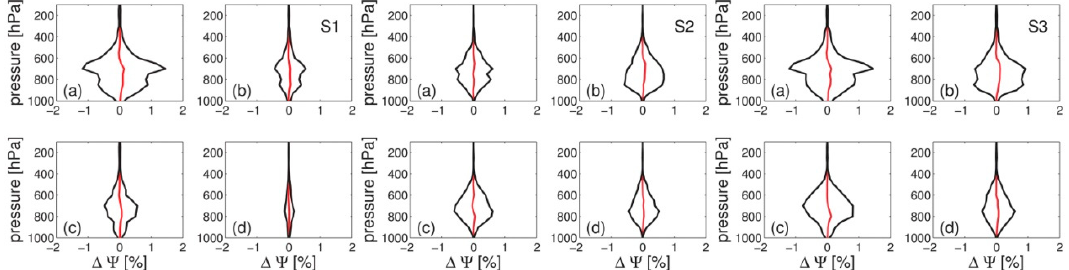
Figure 4. The mean (red) and one-sigma (black) refractivity deviation in percent between the background and the analysis as a function of the pressure. Left panel: ZTDs are assimilated. Middle panel: Horizontal delay gradients are assimilated. Right panel: ZTDs and horizontal delay gradients are assimilated. In each panel the four plots correspond to the grid points surrounding the station Potsdam. The labels (a), (b), (c) and (d) correspond to the grid points to the north-west, north-east, south-west and south-east respectively. Data from the single station Potsdam are assimilated four times per day (0, 6, 12, 18 UTC) for a period of two months (June and July, 2017).